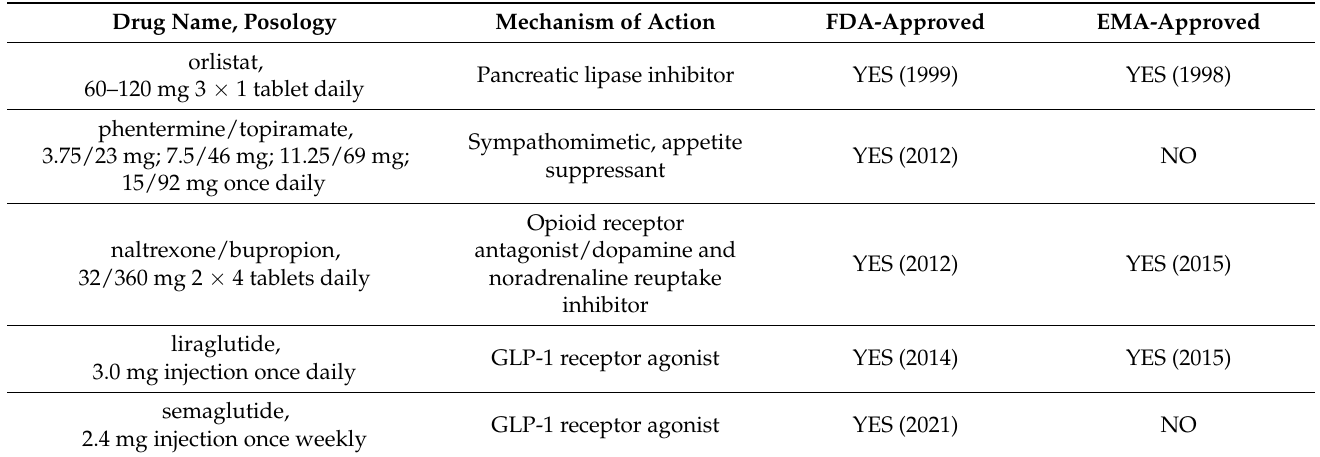
Table 1. Currently approved anti-obesity pharmacological